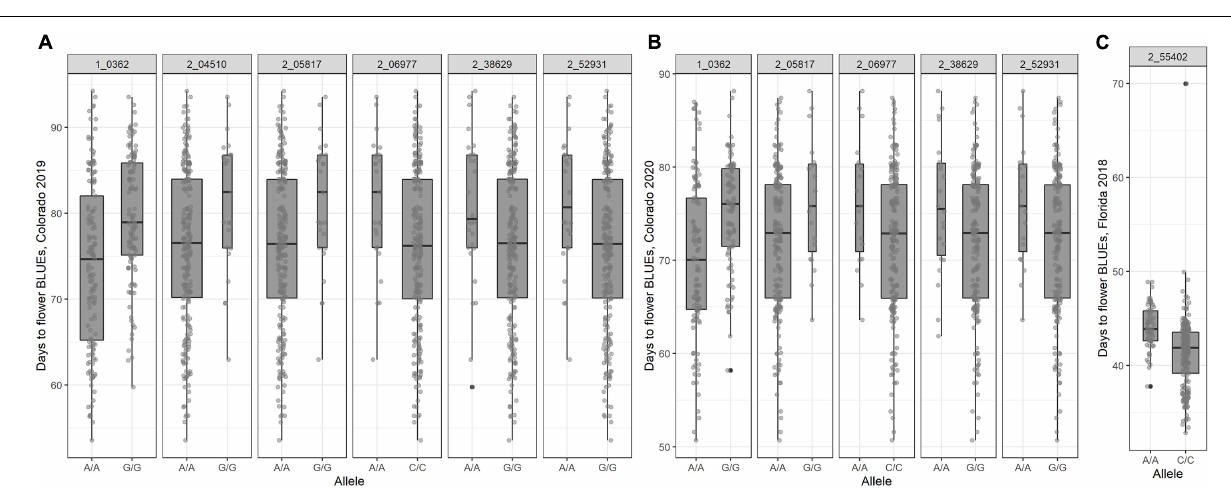
FIGURE 3 | Boxplot of days to flower as affected by the alleles present on the population (A) 368 accessions of the cowpea mini-core collection planted in 2019 in Colorado; (B) 368 accessions of the cowpea mini-core collection planted in 2020 in Colorado; and (C) 292 accessions of the cowpea mini-core collection planted in 2018 in